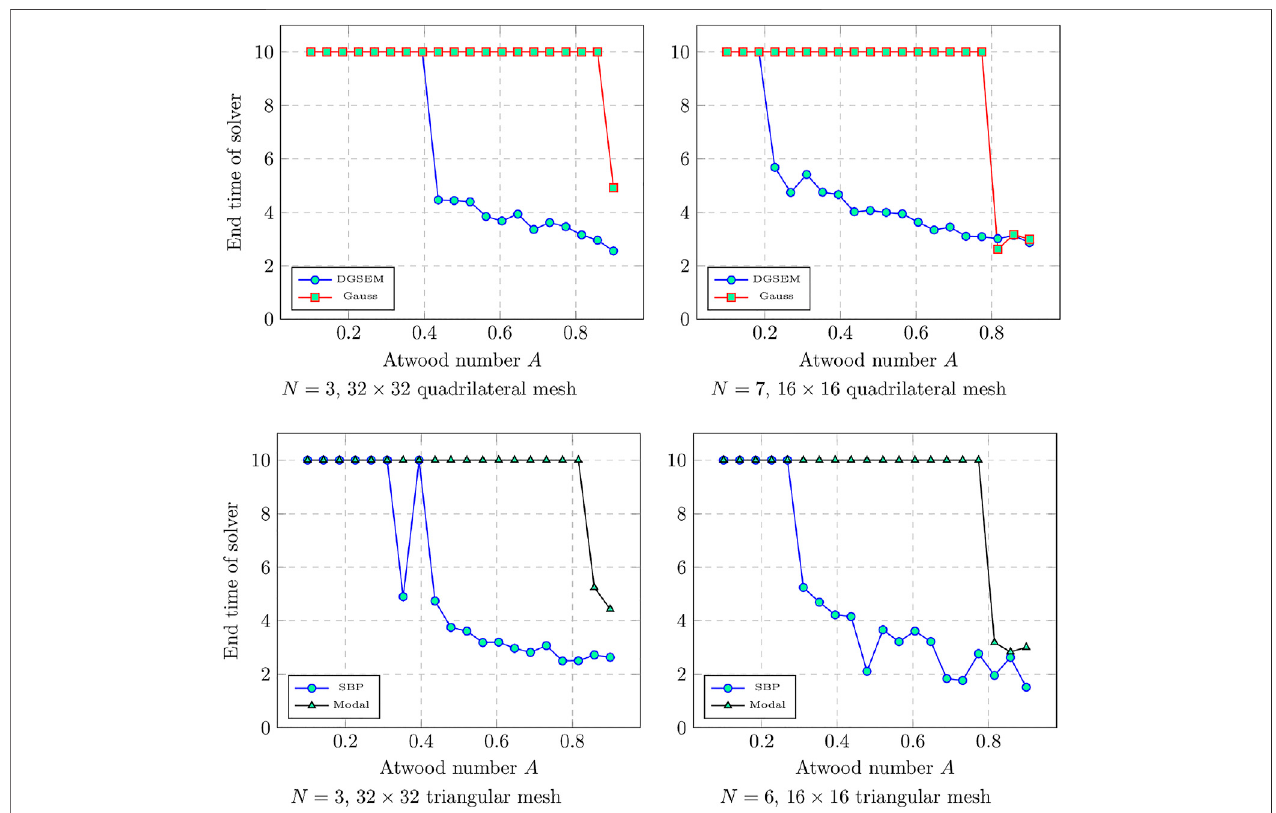
FIGURE5| FinaltimesasolveranuntilasafunctionofAtwoodnumberfortheKelvin-HelmholtzinstabilityforDGSEMandvariousentropystablesolvers.Endtimes less than fi nal time T fi nal = 10 indicate a crash.